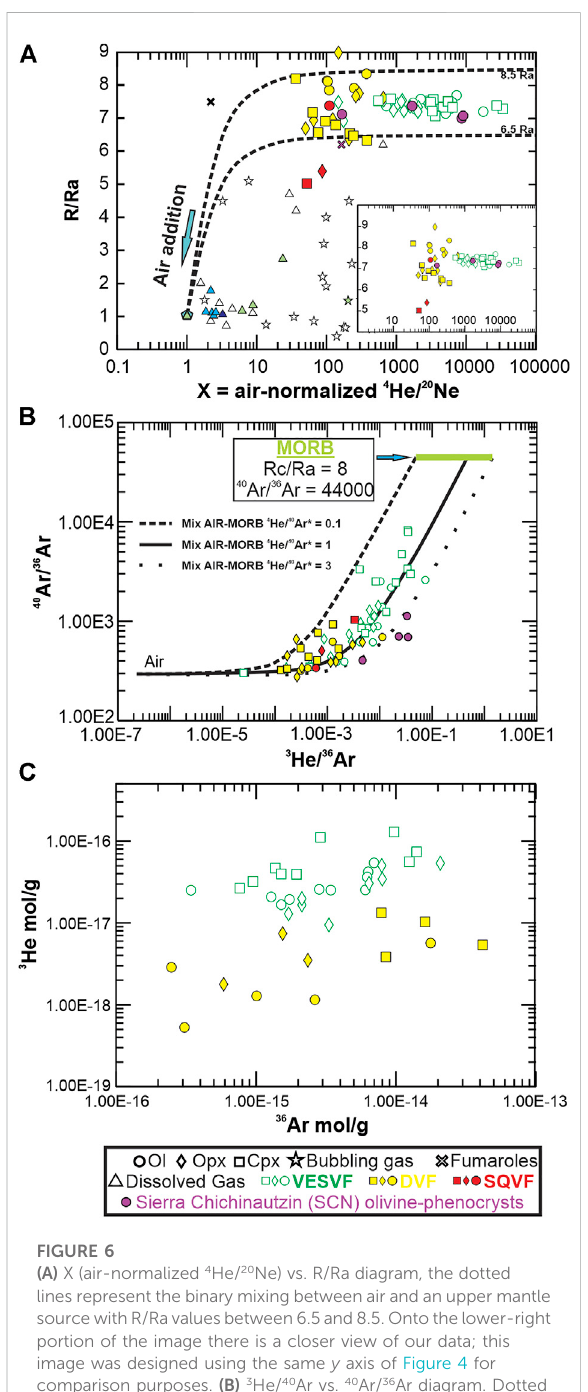
FIGURE 6 (A) X (air-normalized 4 He/ 20 Ne) vs. R/Ra diagram, the dotted lines represent the binary mixing between air and an upper mantle sourcewithR/Ravaluesbetween6.5and8.5.Ontothelower-right portion of the image there is a closer view of our data; this image was designed using the same y axis of Figure 4 for comparison purposes. (B) 3 He/ 40 Ar vs. 40 Ar/ 36 Ar diagram. Dotted and solid lines represent binary mixing between air and an upper mantle source with 40 Ar/ 36 Ar of 298.56 and 44,000, respectively. The endmember 4 He/ 40 Ar* ratios de fi ne the curvature of the mixing hyperbola. SCNolivines fi tthemixing linede fi nedbya 4 He/ 40 Ar* ~3 which is expected considering the magmatic nature of SCN lavas. (C) 36 Ar vs. 3 He concentrations.